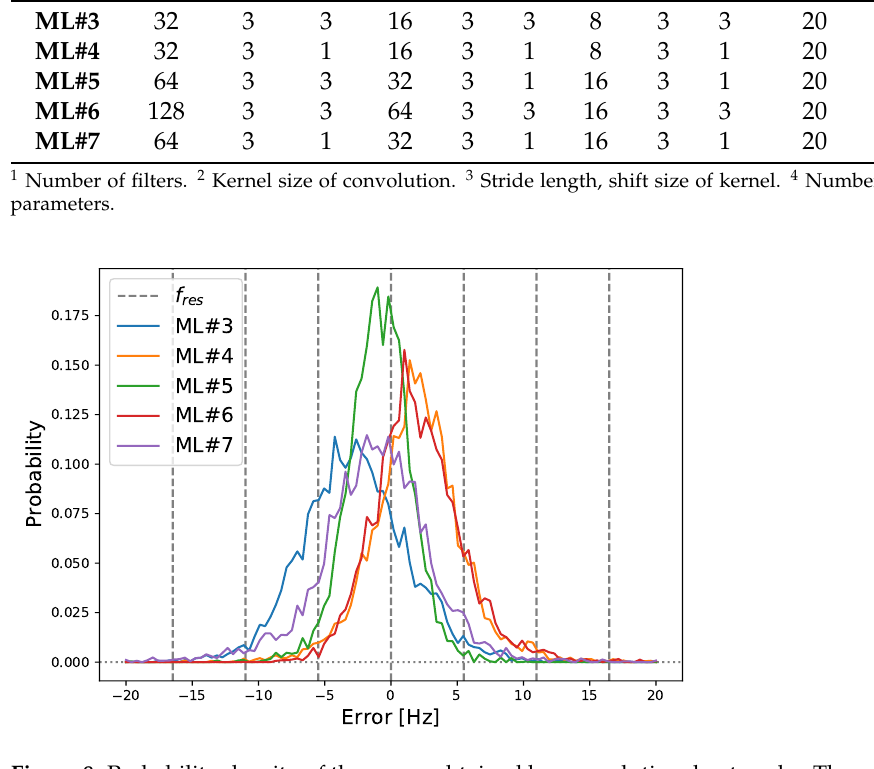
Figure 8. Probability density of the errors obtained by convolutional networks. The errors are the differences between the predicted tunes and the resonances used to simulate the